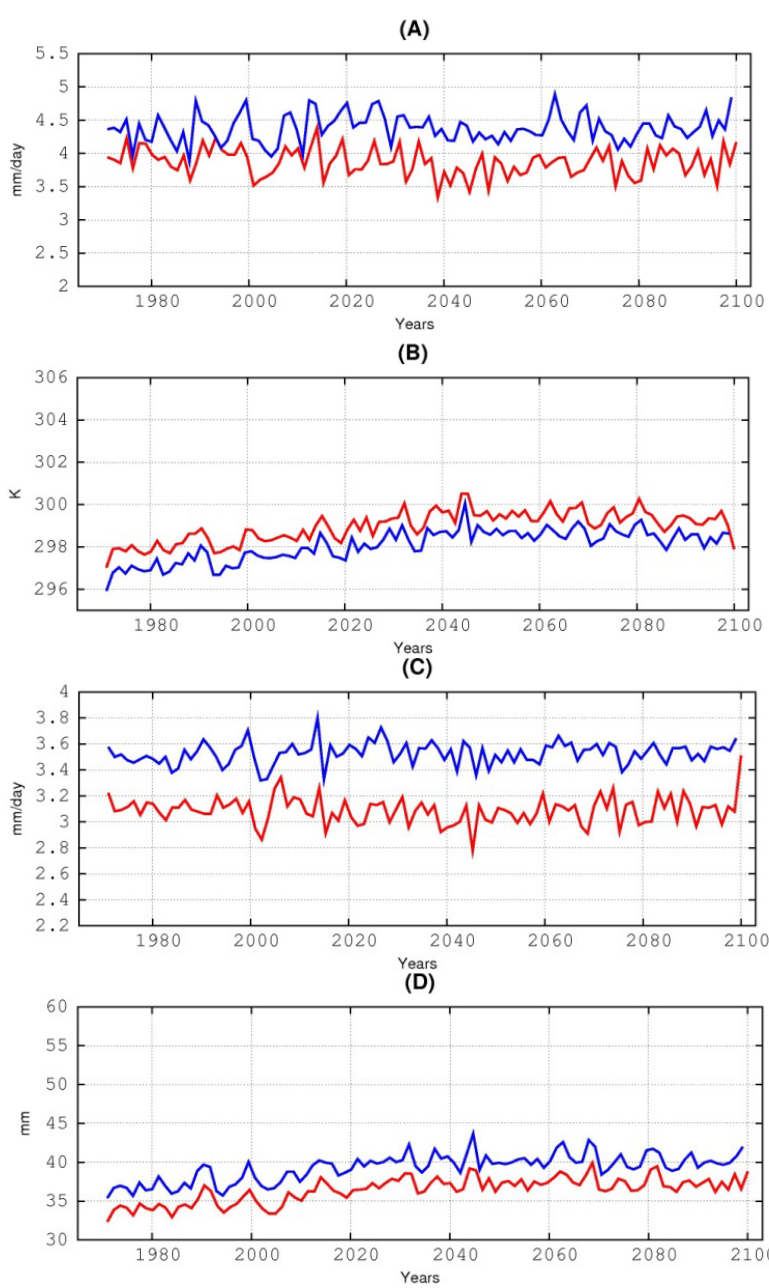
Figure 5. Red (REMO) and Blue (MPI-ESM) curves represent annually averaged values over the region 15°E–30°E; 8°S–10°N for RCP 2.6. The panels show ( A ) Precipitation in mm/day, ( B ) 2m Temperature in Kelvin, ( C ) Evapotranspiration in mm/day and ( D ) Vertically integrated specific humidity in